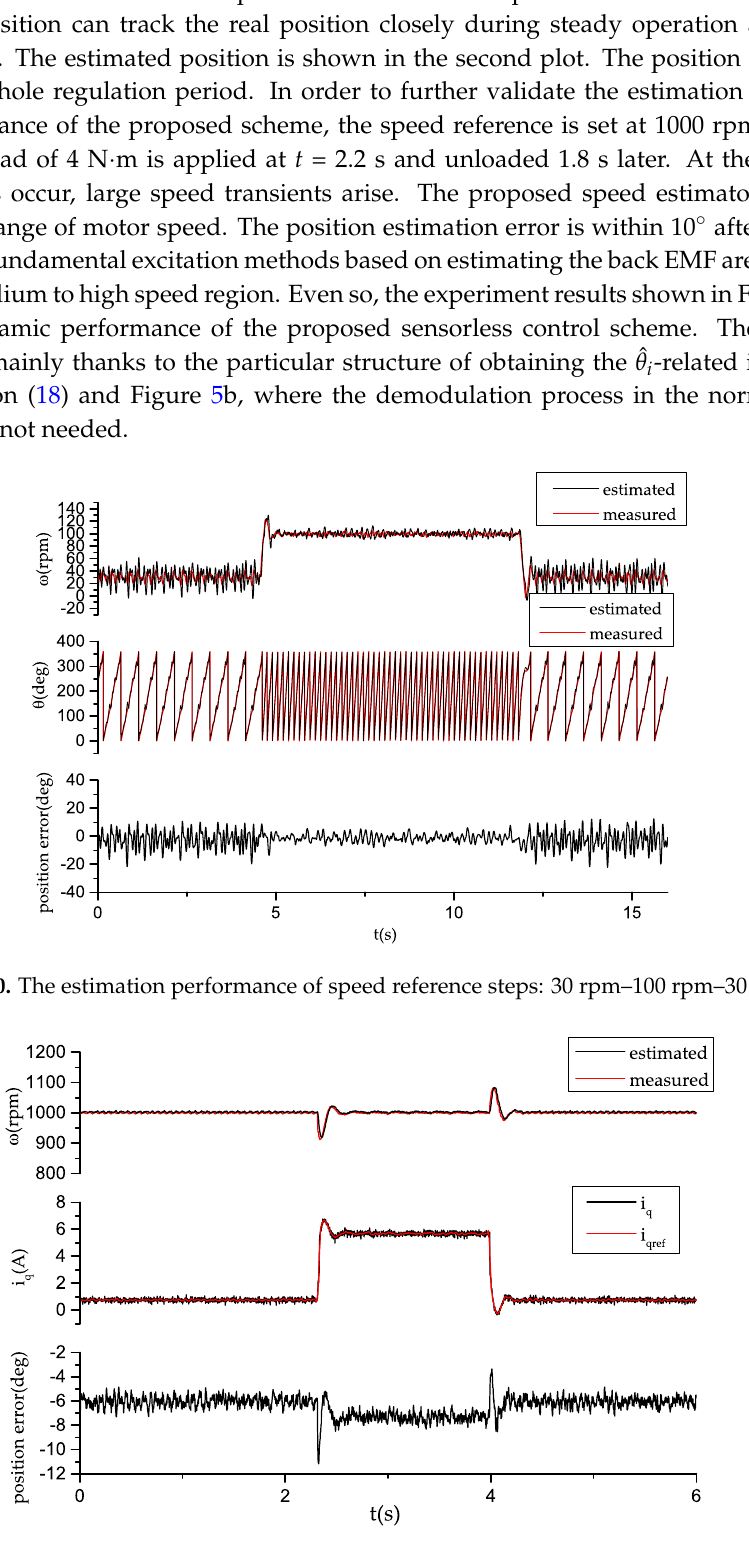
Figure 21. The dynamic performance of the proposed scheme with the speed reference set at 1000